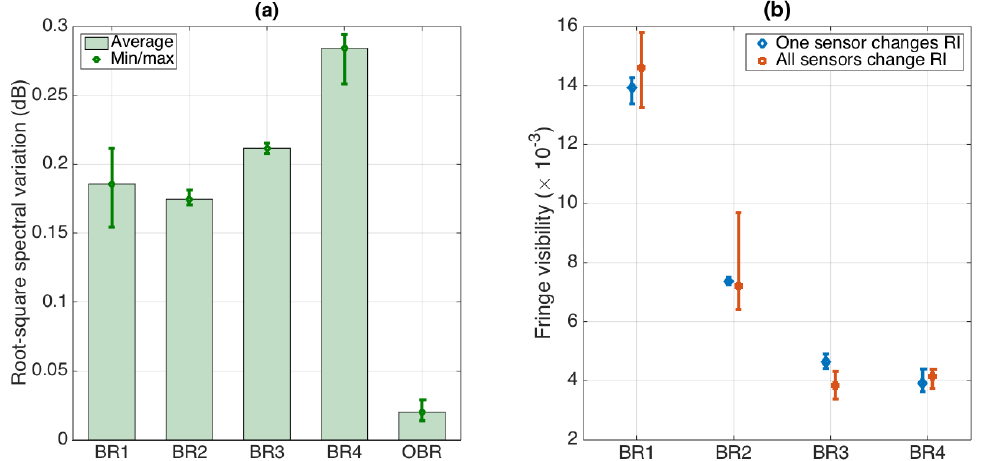
Figure 9. Evaluation of spectral variation metrics for the multiplexed ball resonators. ( a ) Root-square spectral variation between multiplexed sensor and stand-alone sensor, reported for each BR sensor and compared to the OBR limit. The vertical bars show the average over the RI values, and error bars show the minimum/maximum range. ( b ) Fringe visibility of the spectra of each BR sensor, reported when each sensor varies the RI (blue), and when all sensors are subjected to RI change (red). Error bars report the minimum/maximum values; datapoints report the mean value.